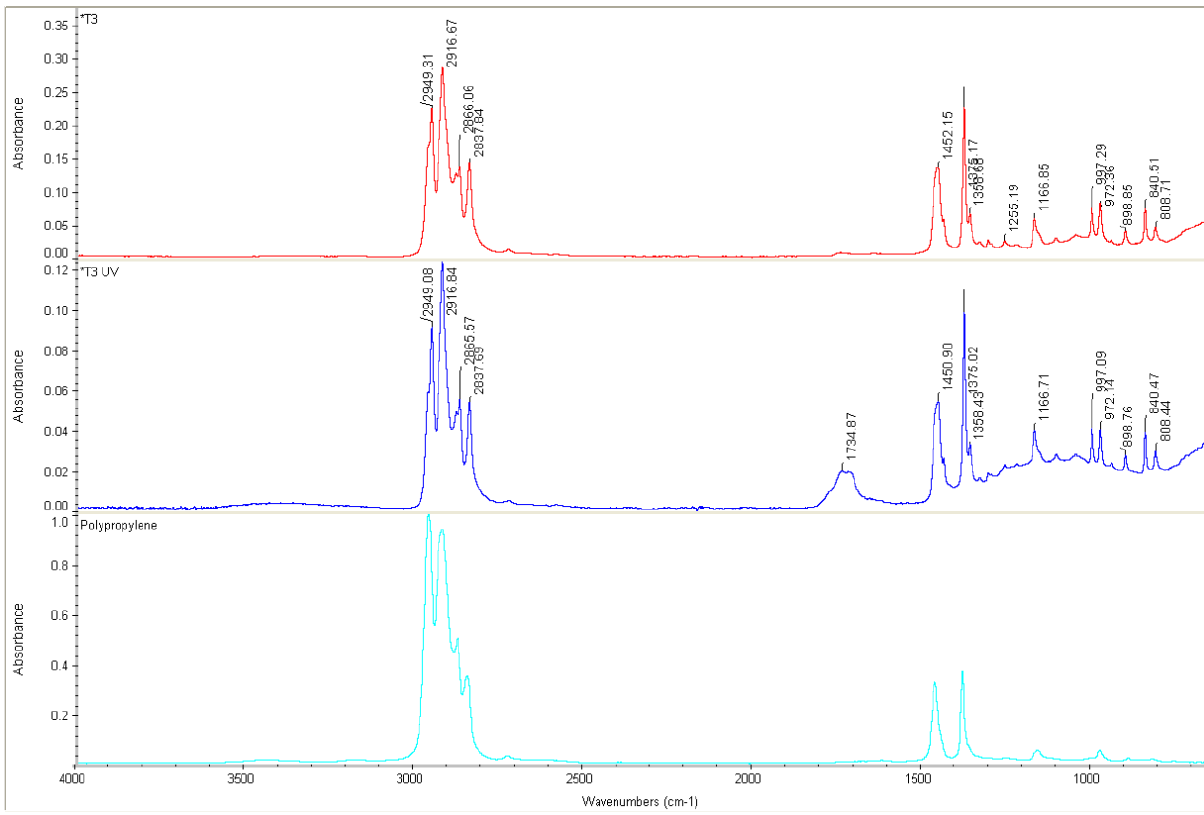
Figure 2: FTIR spectrums of the surface of unweathered and UVweathered WP composite (sample T-3): red of unweathered, blue of weath- ered and green of standard spectrum of polypropylene